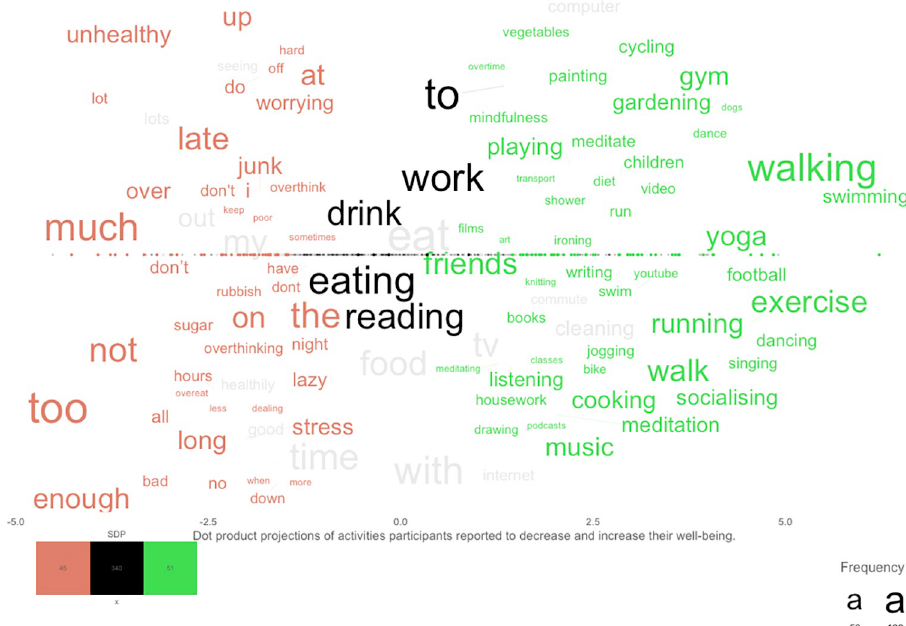
Fig 2. Words for describing activities that decrease and/or increase Subjective Well-Being. Note : Supervised dimension projection plot for activities that increase and/or decrease SWB. Words appearing a minimum of 5 times in the questions combined have been significance tested against a permuted null distribution, N Words significantly belonging to activities increasing SWB are plotted on the right side in green. Words significantly related to activities decreasing SWB are plotted on the left side in red. Black words in the middle are frequent words that do not significantly belong to any group. Grey words significantly belong to the activity category of its position, but occur more frequently in the other category. Word size represents frequency. The position on the dimension projection and the position on the x-axis represent the dot product score. For better visualization, the words are separated on the y-axis, but the y-axis does not represent any